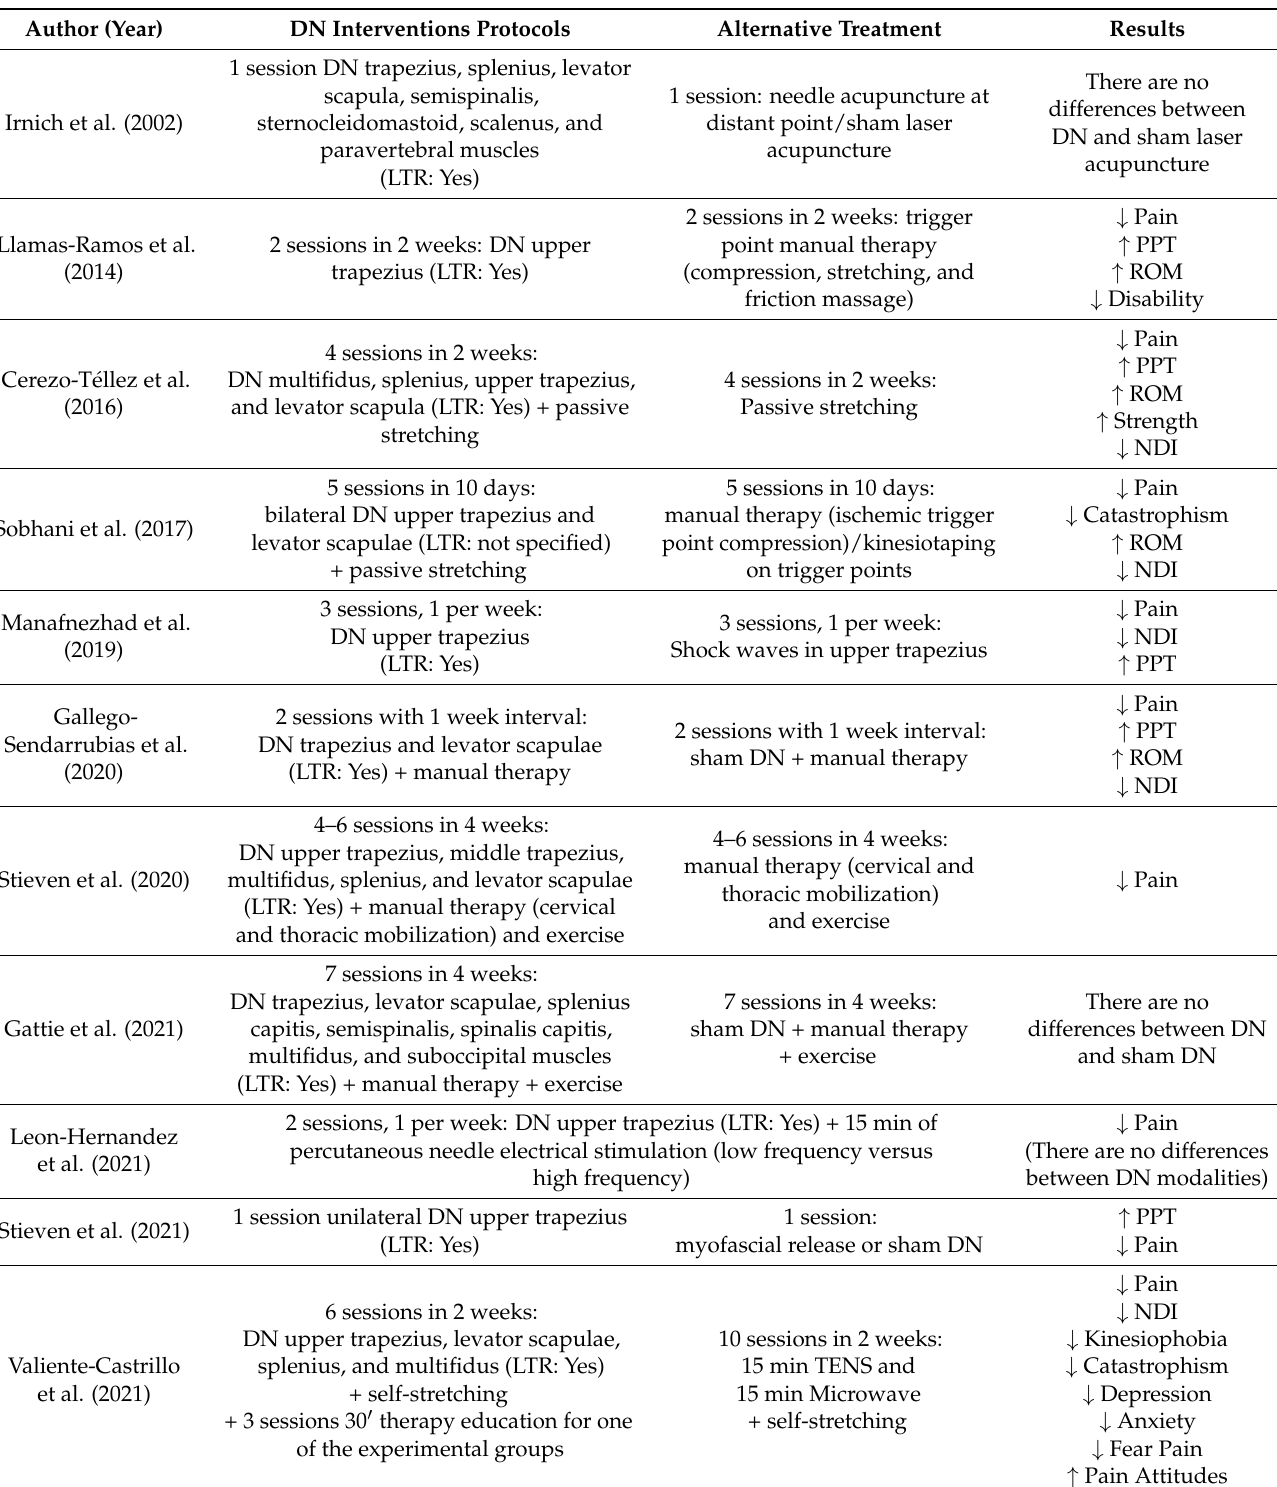
Table 2. Interventions, procedures, and results of the clinical trials based on the application of DN in the treatment of